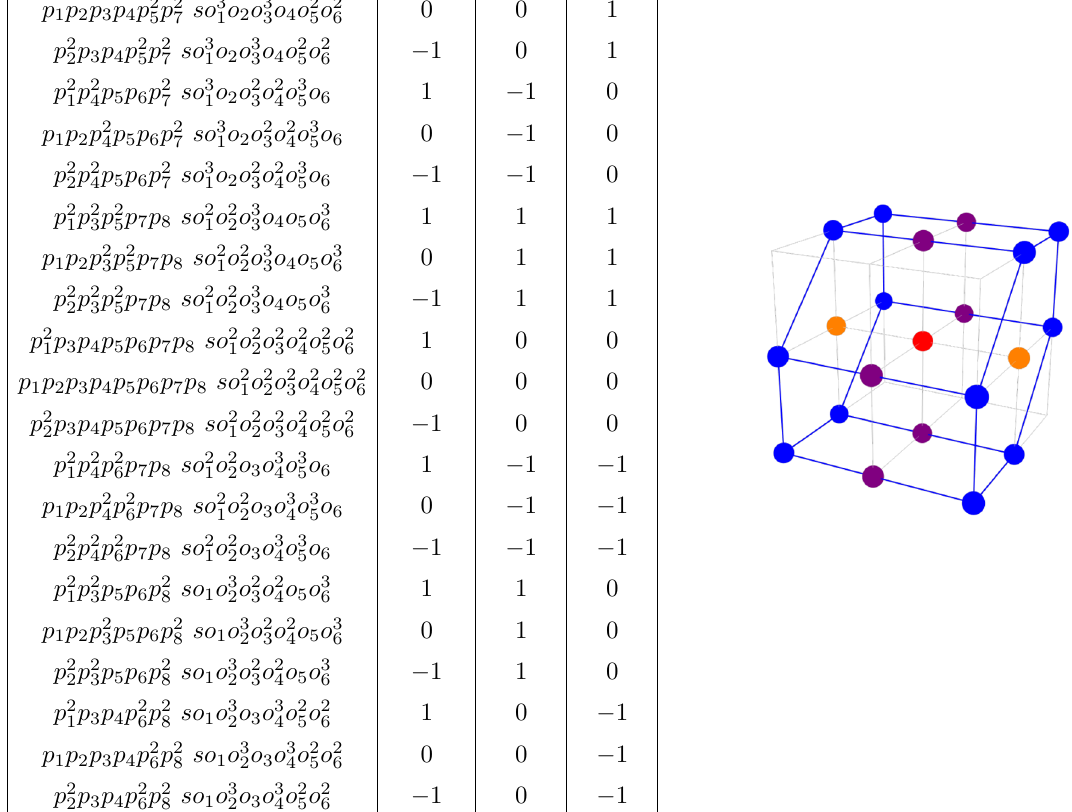
Table 68 . The generators and lattice of generators of the mesonic moduli space of Model 17 in terms of brick matchings with the corresponding flavor